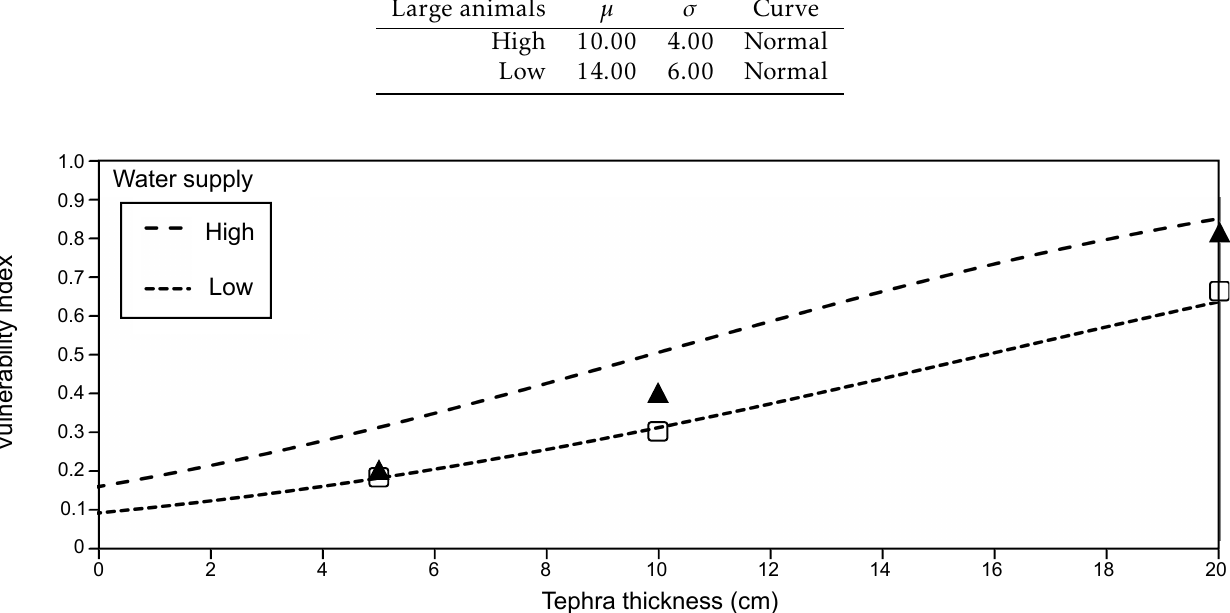
Figure A6: Estimated high and low vulnerabilities of water supply for Federmessergruppen communities exposed to 0–20 cm of tephra fall from the Laacher See eruption. Table A6 – Fitting parameters for vulnerability curves based on water supply in Figure